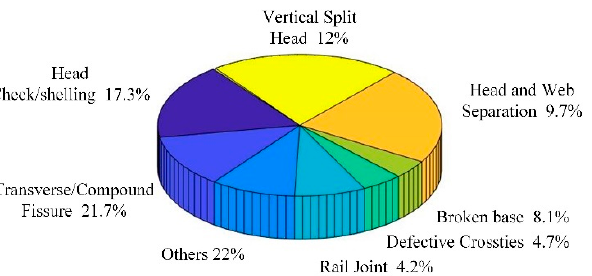
Figure 1. Accidents caused by different types of rail damage between 2005 and 2014.